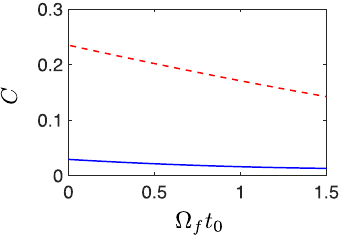
3 i (solid-blue) and FAQUAD (red-dashed) 0 a i t i = = (cid:31)